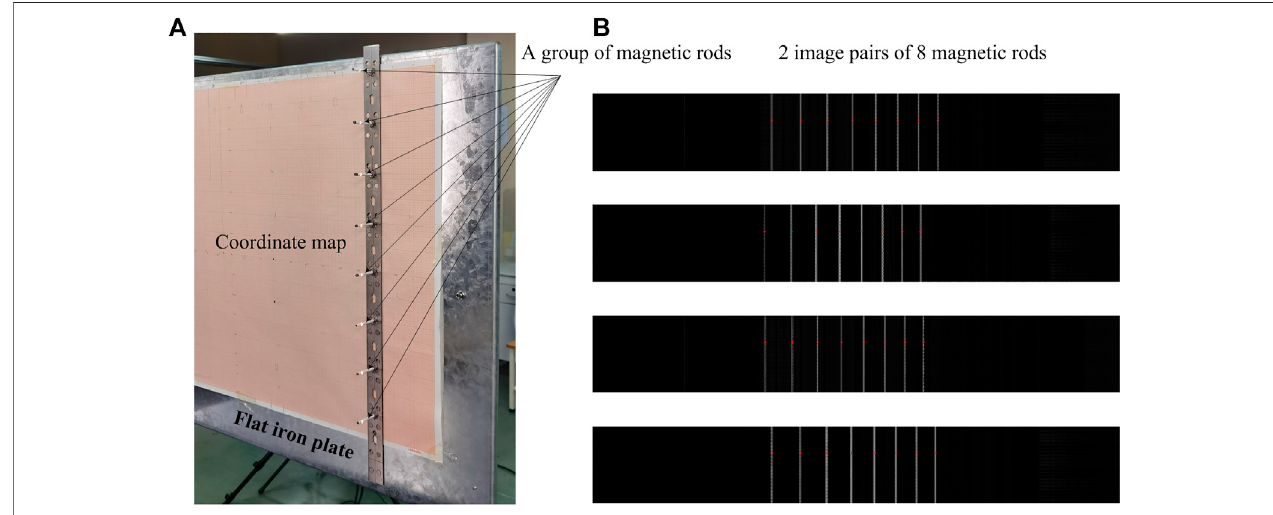
FIGURE 2 | Calibration target and sub-pixel location. (A) Calibration target with a group of magnetic rods (B) Sub-pixel locations of rod centers in the image pairs.